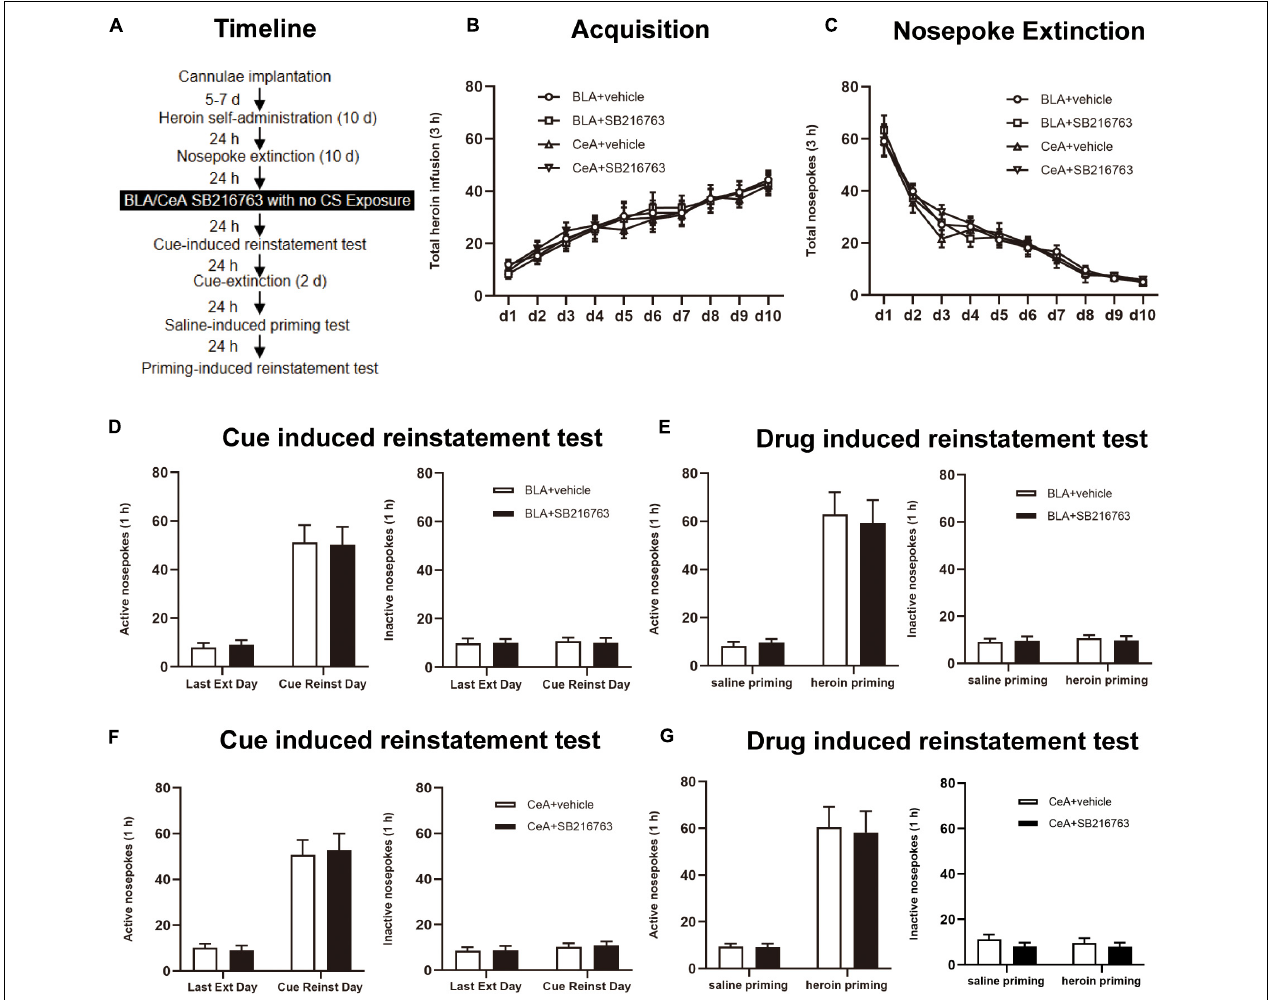
FIGURE 4 | SB216763 treatment without CS retrieval does not affect subsequent cue-induced and heroin-primed reinstatement of heroin seeking. (A) Timeline of heroin self-administration, nosepoke extinction, cue-induced reinstatement test and drug-induced reinstatement test. (B) Total number of heroin infusions during acquisition of heroin self-administration. (C) Total number of active nosepoke responses during extinction training sessions. (D,F) Active (left) and inactive (right) nosepoke responses during the last extinction training session and the cue-induced reinstatement test. (D) Nosepoke responses of rats with BLA drug injection. (F) Nosepoke responses of rats with CeA drug injection. (E,G) Active (left) and inactive (right) nosepoke responses across the saline- or heroin- primed reinstatement test. (E) Nosepoke responses of rats with BLA drug injection. (G) Nosepoke responses of rats with CeA drug injection. n = 10 mice per group. Data are means ± SEM. CS, conditioned stimulus; Ext, extinction; Reinst,